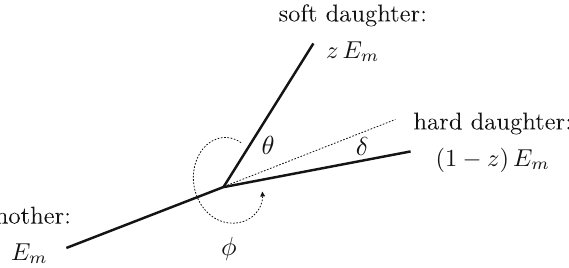
Fig. 6 Local coordinates x = ( z ,θ,φ,δ) that parameterize the momentum-conserving 1 → 2 branching at each step in the cluster- ing tree of a